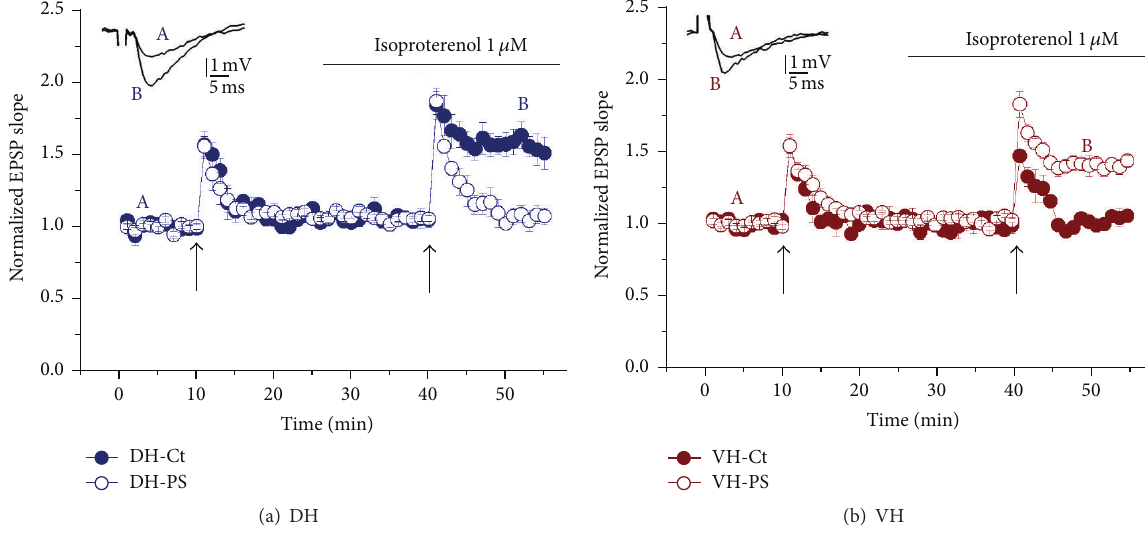
Figure 2: Effect of Isoproterenol, a 𝛽 -adrenergic agonist, on EPSPs recorded in stratum radiatum of DH (a) and VH (b) hippocampal slices from control and prenatally stressed (PS) rats (at 2-3 weeks of gestation). The arrows denote the points at which short tetanic stimulation (35 stimuli at 100Hz) was delivered, twice to one pathway. Short tetanic stimulation, which normally produces only short-term potentiation, applied in the presence of Isoproterenol, produced a full-blown LTP in DH slices of control group (full circles, (a)) and in VH slices of PS rats (open circles, (b)), but not in the other conditions tested ( adapted from Grigoryan and Segal [60]